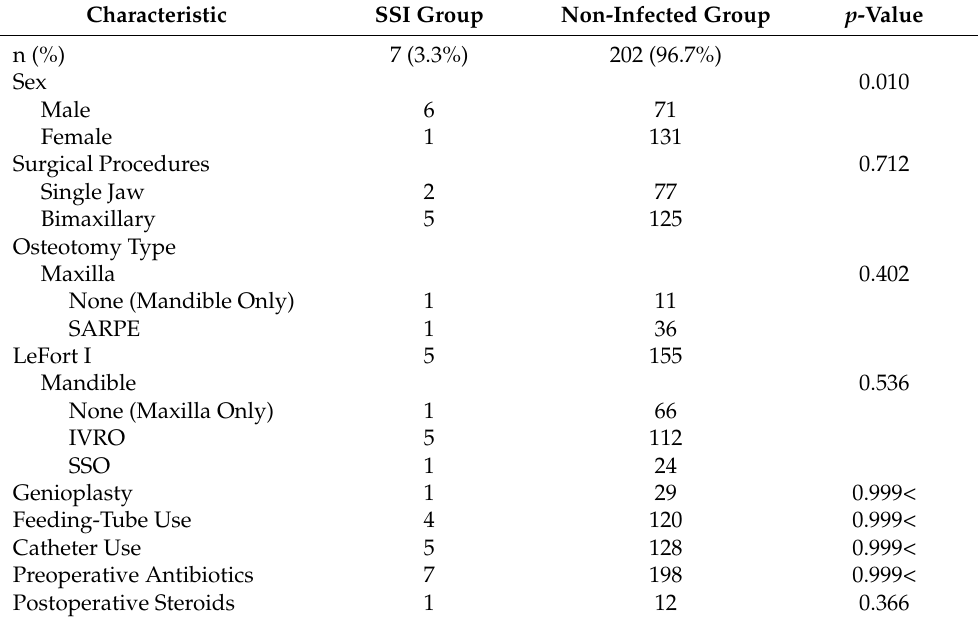
Table 3. Demographic and clinical data of the surgical-site infected and non-infected groups.